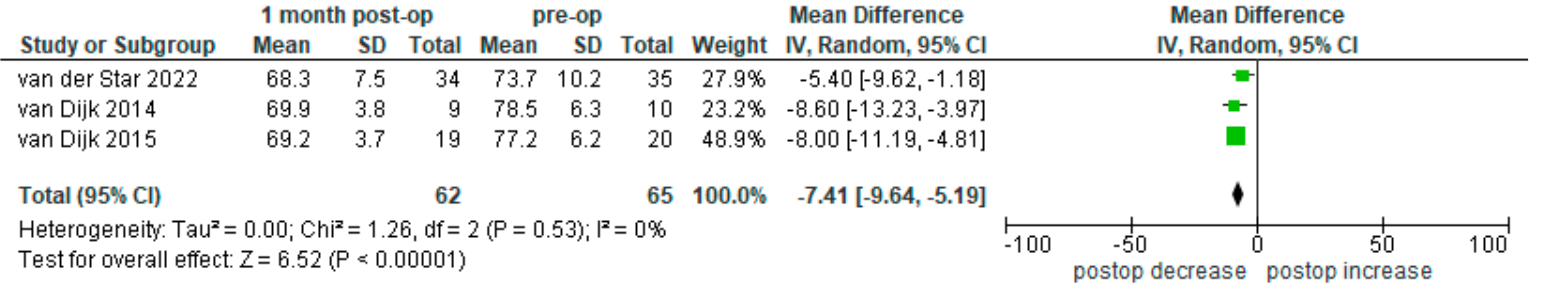
Figure A5. Di ff erence in maximum keratometry across 3 studies [27,31,43].